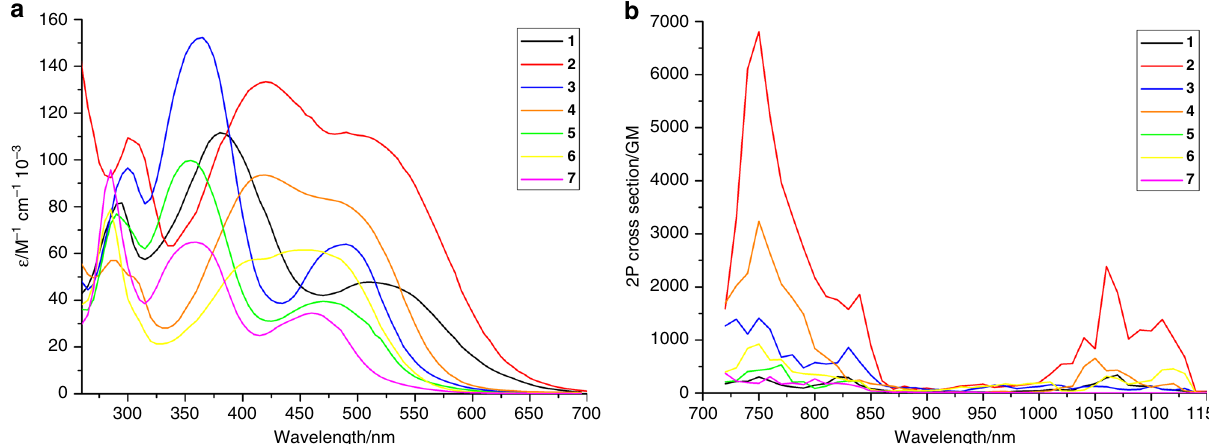
Fig. 2 Absorption spectra of the complexes 1 – 7. a 1P absorption spectrum in acetonitrile and b 2P absorption spectrum in